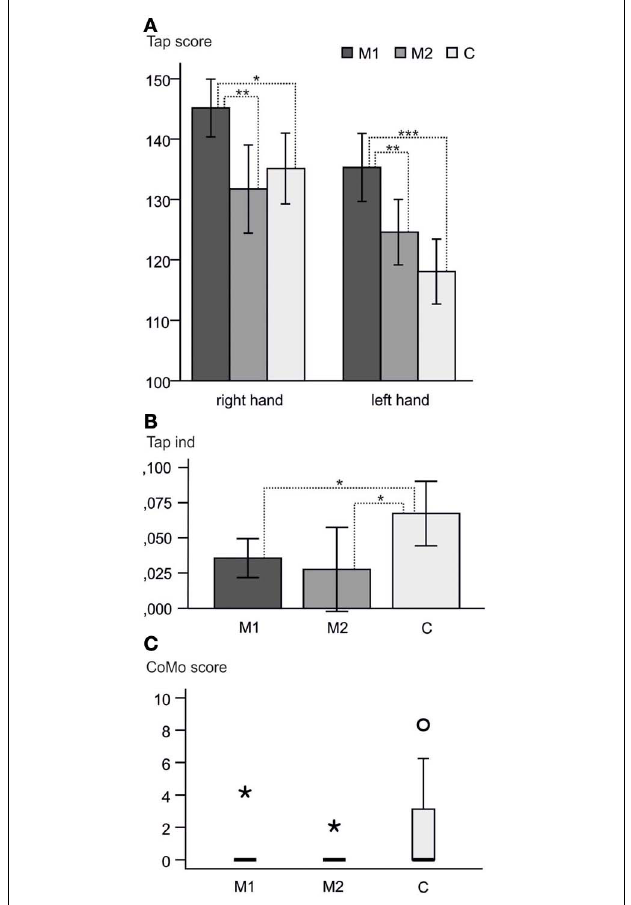
FIGURE 1 | Behavioral results. (A) Raw tapping scores right and left hand and 95% confidence intervals. M1 reached higher scores than M2 and C in both hands. No significant difference was found between M2 and C ( p > 0 . 05). (B) Means and 95% confidence intervals of the tapping indices. M1 and M2 showed significantly lower tapping index means than C, indicating a more symmetric motor performance. (C) Boxplot of the CoMo scores. Only two of the musicians showed co-movements at all (one in each of the subgroups; asterisks). Round circle = outlier within the control group. ∗ p < 0 . 05; ∗∗ p < 0 . 01; ∗∗∗ p < 0 .